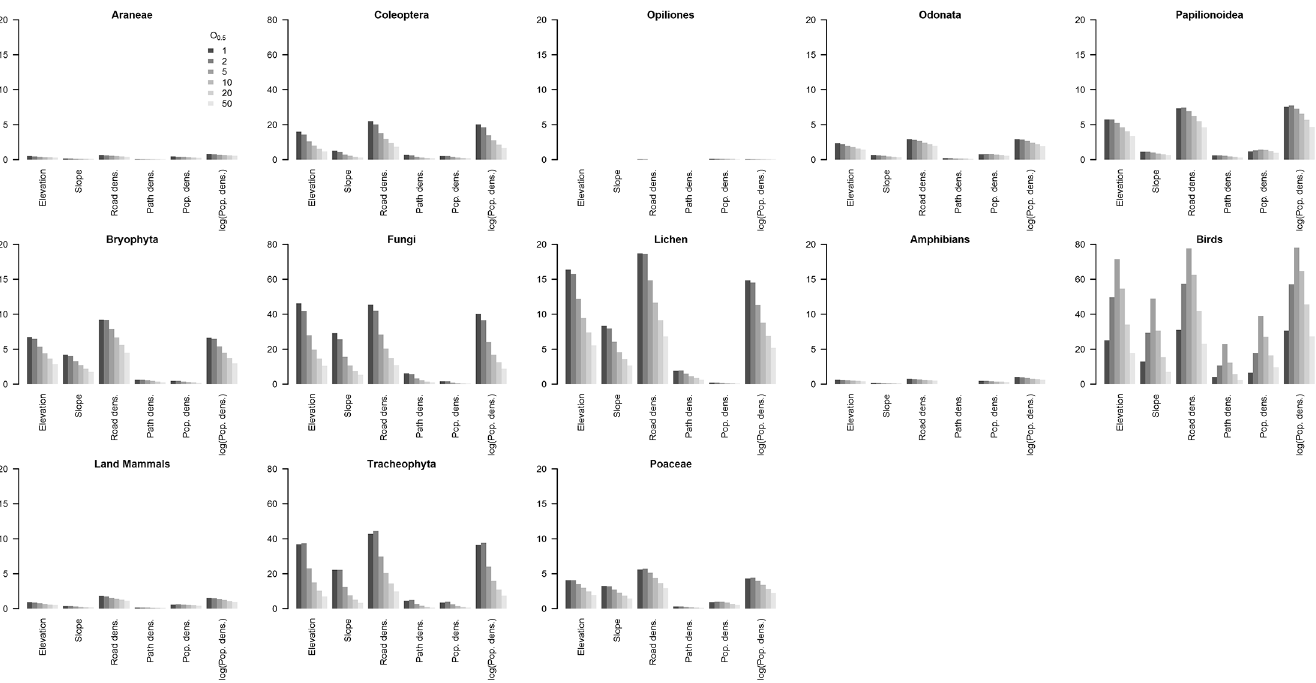
Fig 3. The percent deviance explained (R 2 ) when each geographic variable was modelled independently against ignorance score. The percent deviance explained (R 2 ) when each geographic variable was modelled independently against ignorance score at varying levels of O 0.5 (shading indicates the gradient from O 0.5 = 1 at the darkest, through 2, 5, 10, 20 to 50 at the lightest). R 2 was calculated for the best fit model in each case (either linear or quadratic depending on Δ deviance; Tables A and B in S1 File). Note that the range of y-axes varies (a maximum of either 20 or 80) to accommodate the large variation amongst taxa in R 2 values